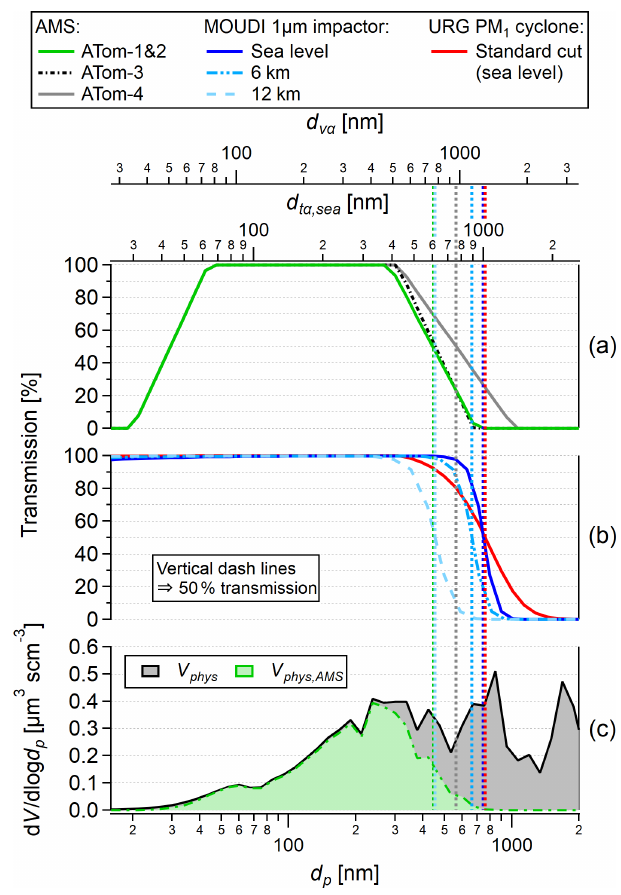
Figure 3. Transmission curves (a) for AMS during ATom-1 (same for ATom-2), ATom-3, and ATom-4 deployments and (b) for MOUDI 1µm stage impactor operated at sea level, 6km, and 12km (at T = 293K as typical cabin temperature and P based on the US standard atmosphere) (NOAA et al., 1976) and for URG PM 1 cy- clone (sea level). (c) Average AMP volume distribution ( V phys ) and the fraction observed by AMS ( V phys , AMS ) for ATom-2. Particle size in geometric diameter ( d p ; reported by AMP), vacuum aerody- namic diameter ( d va ; AMS), and aerodynamic diameter ( d ta ; for the MOUDI impactor and URG cyclone; note that the MOUDI trans- missions at 6 and 12km are accurate on the d p and d va axes but slightly off on the sea level d ta axis due to the change in slip correc- tion) are shown as the three horizontal axes, all for dry particles. The 50% large particle cutoff sizes for AMS, MOUDI, and URG are listed in Table S1 based on d ta , d va , and d p . Because URG cyclone is normally used to size-select ambient particles for ground studies, the equivalent dry cut would be smaller than 1µm, approximately 0.8µm based on the aerosols sampled in this study (Sect.